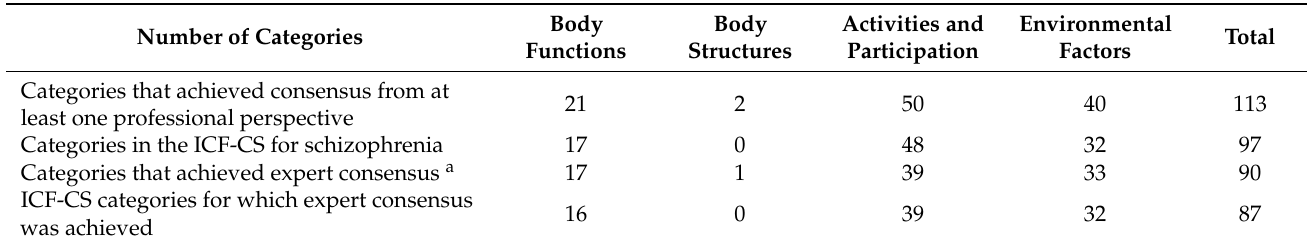
Table 2. Number of categories that reached expert consensus and comparison with the categories included in the complete version of the ICF-CS for